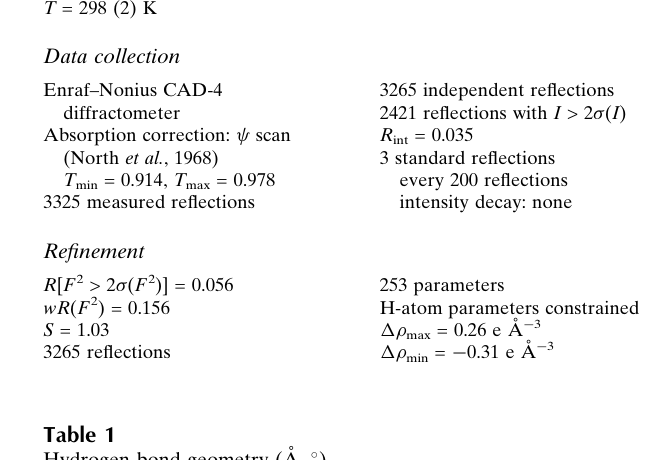
Hydrogen-bond geometry (A˚ , (cid:2)